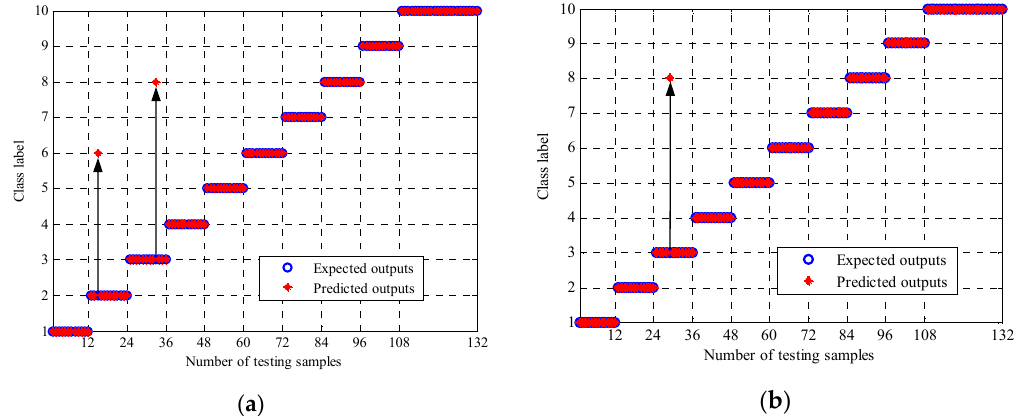
Figure 7. Misclassified testing samples with ( a ) the non-discriminative features and ( b ) discriminative